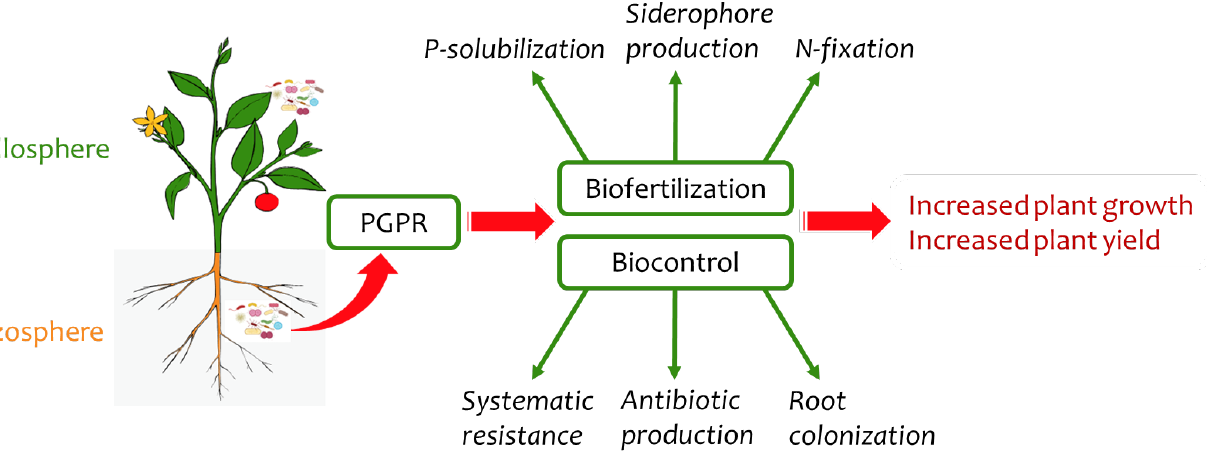
Figure 2. Plant probiotic bacteria and their mechanism of action (adapted from